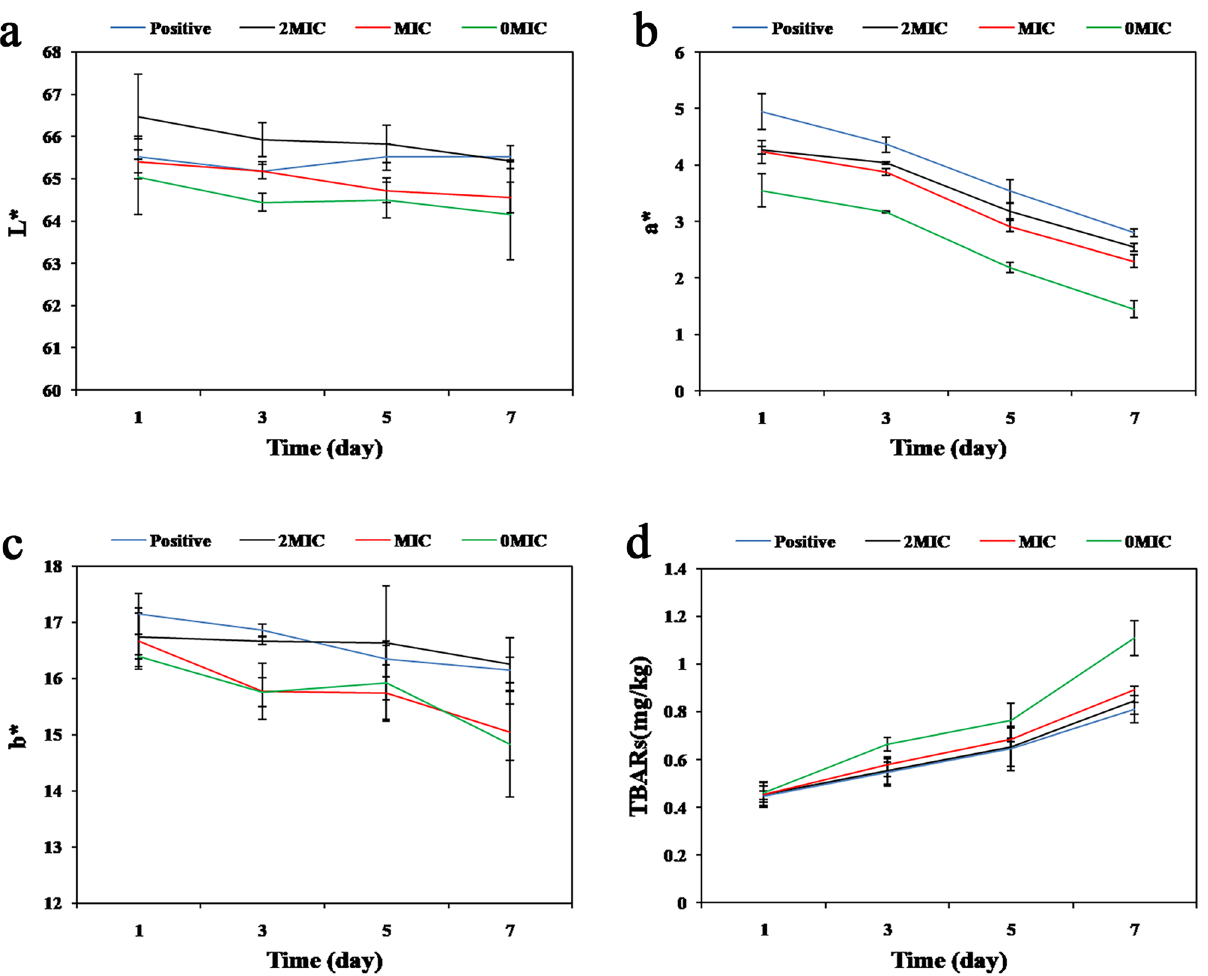
Figure 4. The effects of different concentrations of PCA on the pork ( a ) L* value, ( b ) a* value, ( c ) b* value, and ( d ) TBARS content. Error bars represent the standard deviation (n =